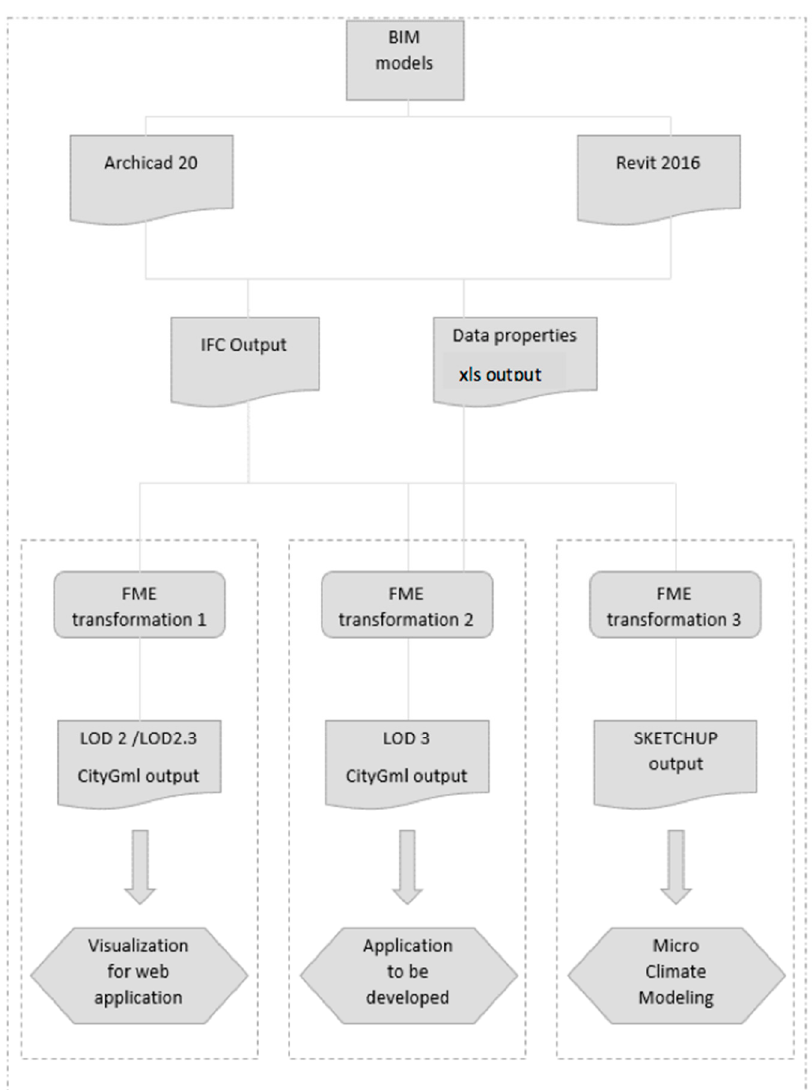
Figure 1. Methodology diagram.